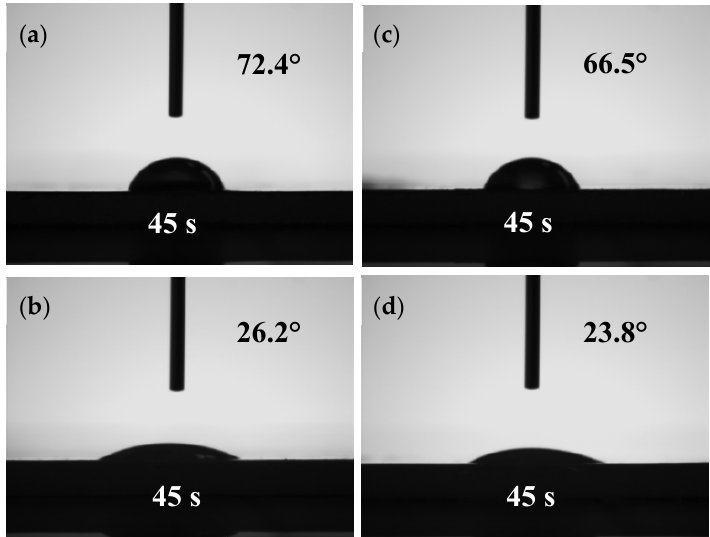
Figure 7. WCA (water contact angle) of LCNF and CNF films produced from fibers and parenchyma cells. ( a , b ) F-LCNF and F-CNF, respectively; ( c , d ) P-LCNF, P-CNF, respectively.